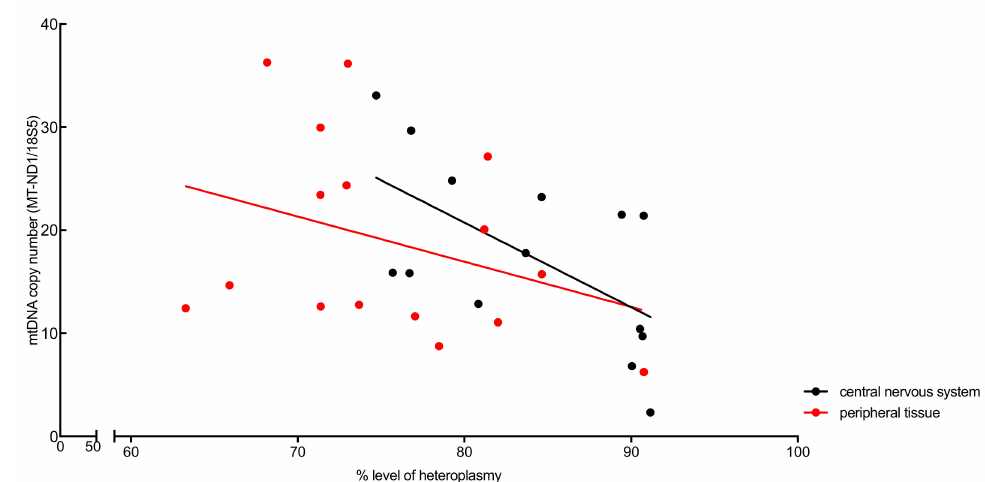
Figure 1. Correlation of heteroplasmy levels (%) and mtDNA copy number (MT-ND1 / 18S5) in the central nervous system tissue (black circles) and in the peripheral tissues (red circles) from the case report patient. In both the central nervous system samples and the peripheral tissues, higher levels of heteroplasmy correlated with lower mtDNA copy number, however only significantly in the central nervous system samples ( p <